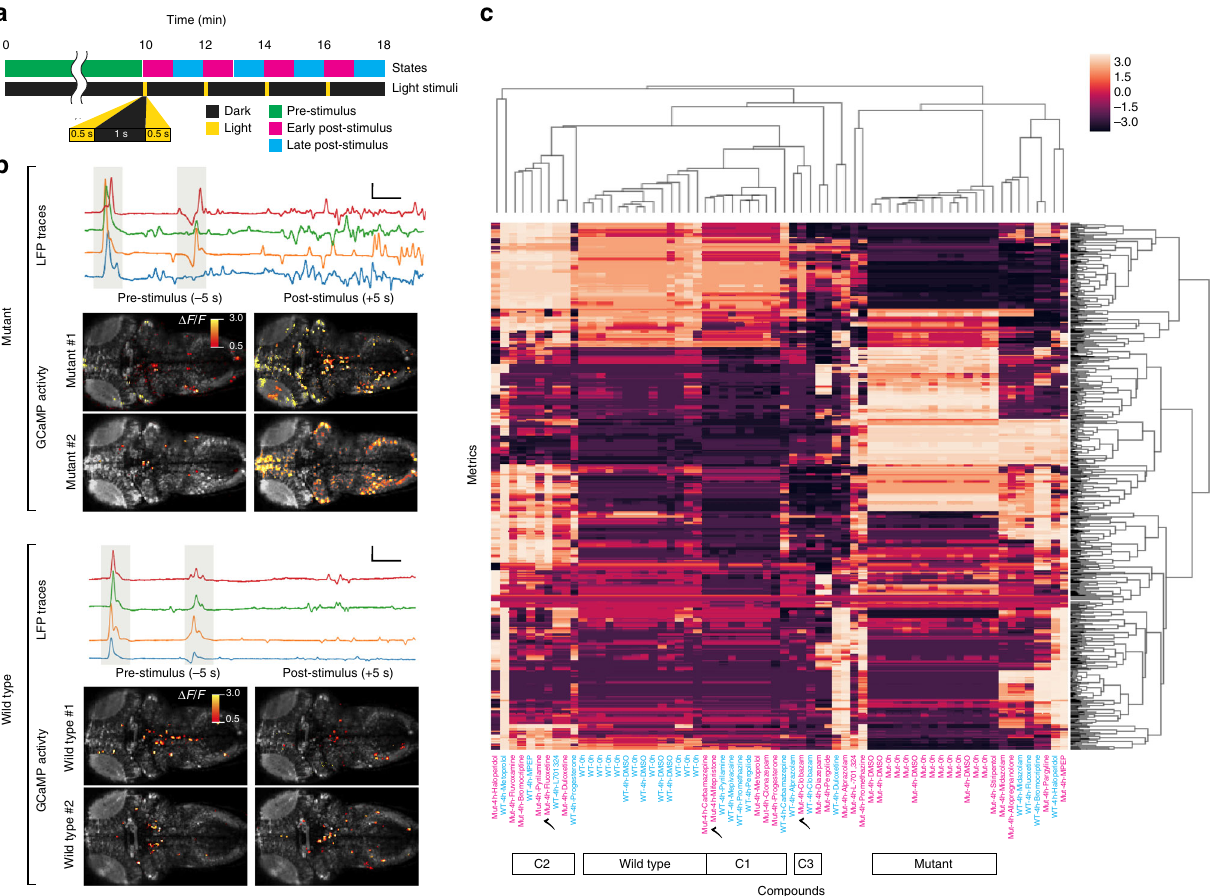
Fig. 2 Functional brain connectivity fi ngerprints identify polytherapy candidates. a Schematic representation of the light stimulus parameters and associated activity states used for functional connectivity fi ngerprinting. GCaMP activity is recorded for 10 min in the absence of light stimuli (pre-stimulus state). Seizure-inducing white light stimuli are then applied every two minutes. GCaMP recordings during this period are subdivided into early post- stimulus (0 – 60 s after the stimulus) and late post-stimulus (60 – 120 s after the stimulus) states during subsequent analysis. b Representative local fi eld potential recordings (LFP traces; upper panels) and single frames from brain-wide GCaMP recordings (GCaMP activity; lower panels) in scn1lab mutants (top) and wild-type controls (bottom) illustrating response to light stimuli at 5 dpf. LFP trances and GCaMP activity are recorded independently. Gray bands on LFP recordings indicate the timing of the two 500 ms light pulses. Scale bars show 0.5 s ( x -axis) and 1 mV ( y -axis). GCaMP images show activity from a single z-plane 5 s before the fi rst pulse (pre-stimulus) and again 5 s after the second pulse (post-stimulus). Supervoxels with signi fi cant changes in fl uorescence activity ( Δ F/F) are shown in color. c For each compound, a 165-metric functional connectivity fi ngerprint is generated based on correlation coef fi cients between active supervoxels in all 55 pairs of brain areas during each of the three activity states. Each square represents the deviation of the correlation for the compound in question ( X ) from the mean correlation for all compounds ( X mean ) in the brain area pair being analyzed, normalized by standard deviation [( X − X mean )/ X STD ]. The analysis is carried out in both mutants (Mut, magenta text) and sibling controls (WT, cyan text) prior to compound addition (0 h) and again at 4 h post-exposure to the compounds in 1 % DMSO (4h). Fingerprints are analyzed by hierarchical clustering to identify compounds that modulate functional connectivity networks in similar ways. We identify the three most distinct clusters (C1, C2, and C3) that fall closest to the wild-type cluster. We then select the compound in each activity cluster that most effectively restores functional connectivity in scn1lab mutants based on Euclidean distance from the wild-type cluster (indicated by checkmarks). Source data are provided as a Source Data fi fi ve homozygous mutants and fi ve sibling controls per compound. Prior to compound exposure, light-sheet imaging is performed on all larvae to establish baseline functional con- nectivity data for each test group. During pre-exposure imaging, homozygous mutants can be reliably distinguished from sibling controls based on the intensity and duration of GCaMP activity. embedded larvae are transferred from the light-sheet imaging pounds at the speci fi ed concentrations using our high-throughput platform. Larvae are incubated in test compounds plus 1% dimethyl sulfoxide (DMSO) for 4 + h, at which point they are transferred back into the imaging chamber and a post-exposure